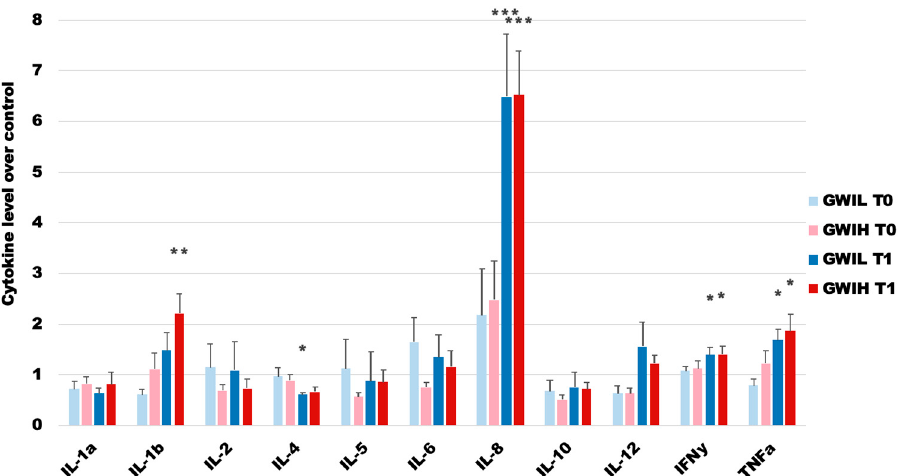
Figure 1. Human blood cytokine levels in PTSD-based GWI subtypes as compared to HC at rest (T0) and peak exercise during a maximal graded exercise challenge (T1). Individual cytokine values are normalized to the HC values, and bars represent the mean ratios ± SEM for each cytokine. Significance was set at * p < 0.05, ** p < 0.01, and *** p < 0.001 as compared to HC. The false discovery rate, as calculated via Storey et al. [48] , was < 0.1 for all significant measures. Values are found in Table S1.